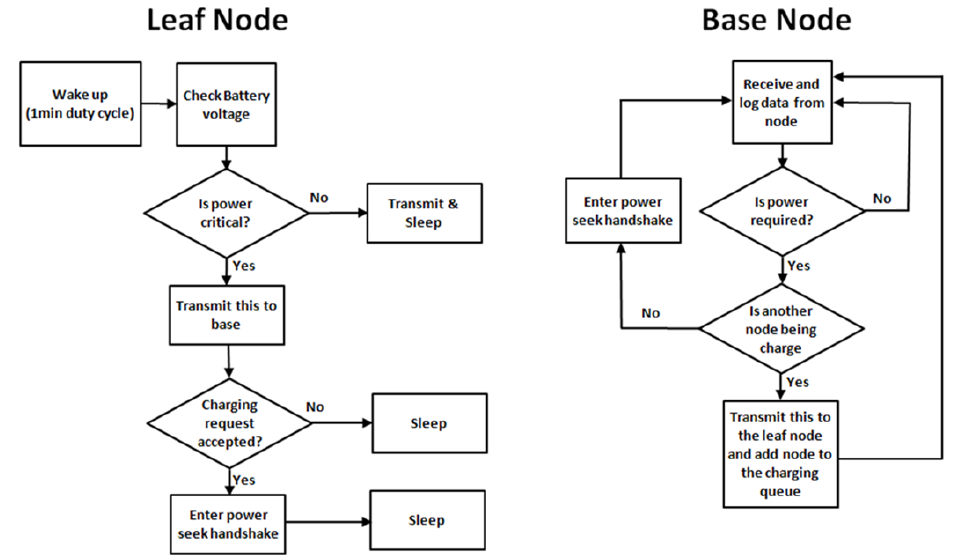
Figure 4. The programming process flow diagrams used for the leaf and base